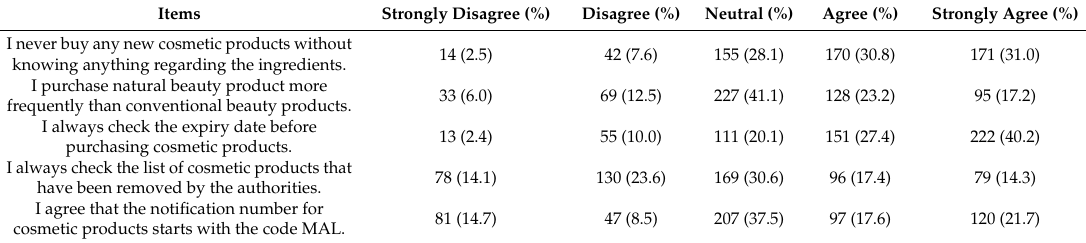
Table 5. Response of participants to the questions on attitude towards cosmetic safety.